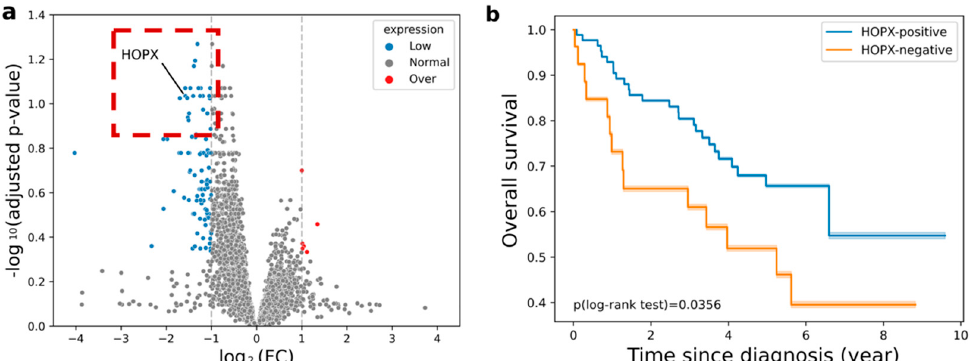
Figure 2. ( a ) Volcano plot for the relationship between differential expression (log 2 FC) and statistically significant difference of mean expressions ( − log 10 (adjusted p -value)) obtained from short and long survival groups in terms of 10,674 genes including HOPX (log 2 FC = − 1.575, p -value = 1.9 × 10 − 4 , adjusted p = 0.092). The blue dot represents the low expression gene before correction, non-adjusted p < 0.05. The red dot represents the over-expression gene before correction, non-adjusted p < 0.05; ( b ) Kaplan–Meier curves of survival in the training dataset ( p = 0.0356, log-rank test). Orange and blue curves represent HOPX-negative (poor survival) and HOPX-positive (good survival) groups, respectively.